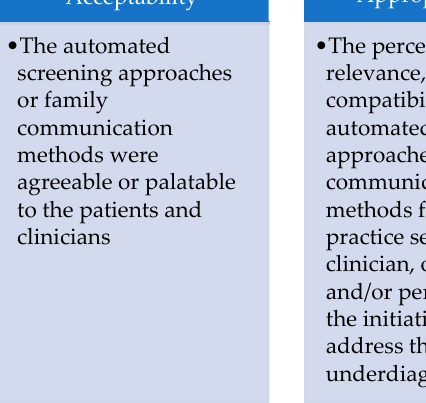
Figure 3. Study-specific definitions of the implementation outcomes: acceptability, appropriateness, and feasibility.